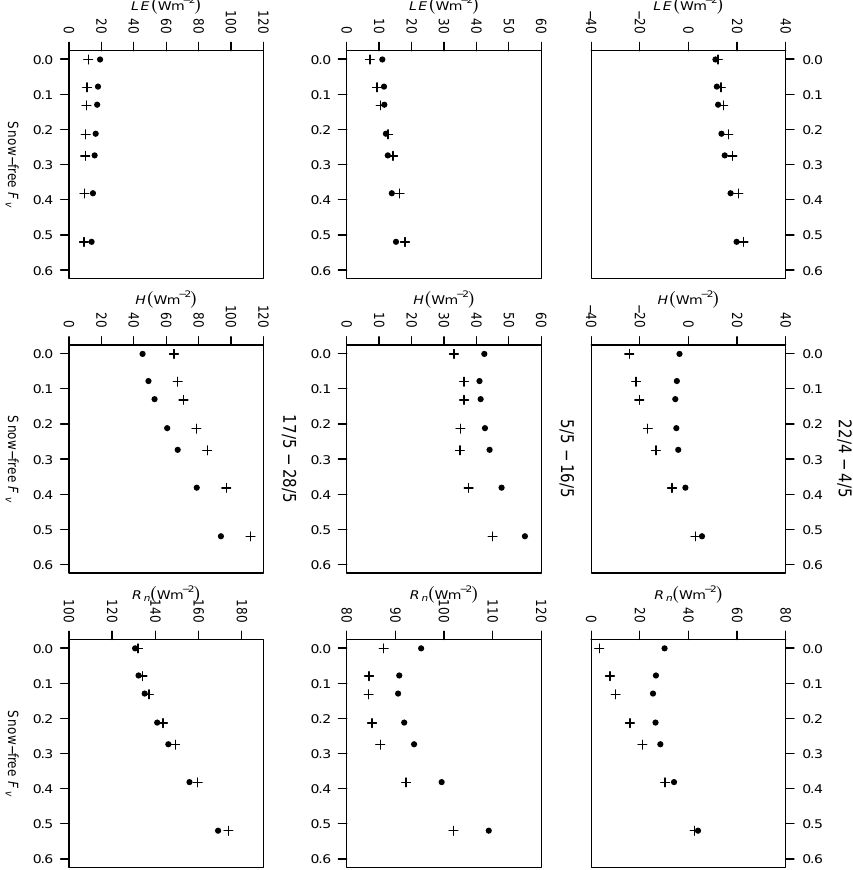
Figure 12. Area-averaged latent heat flux, sensible heat flux and net radiation as functions of snow-free vegetation fraction for simulations with topography (dots) and without (crosses) over three time